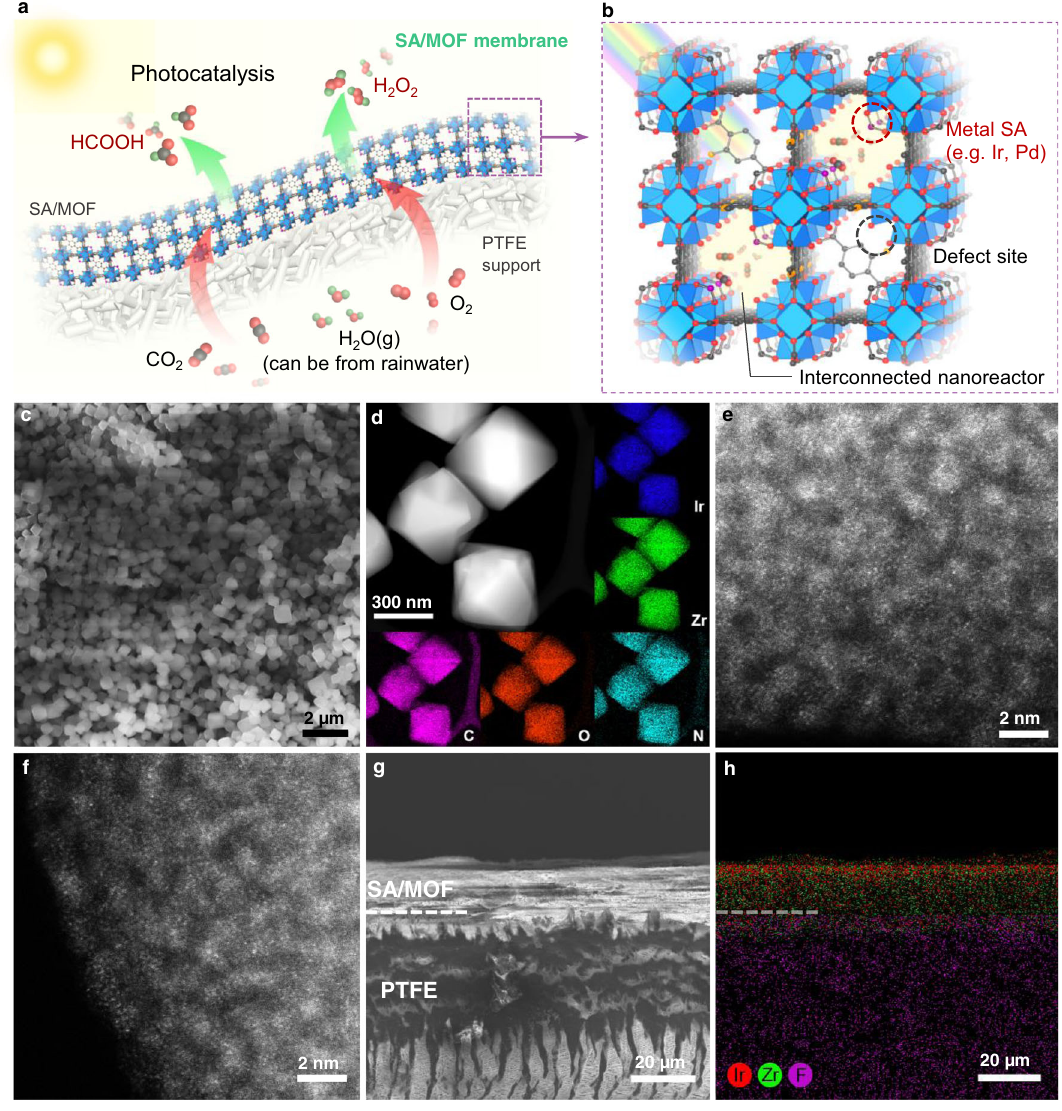
Fig. 1 Schematic illustration and structural characterization of the SA/MOF membranes. a Humidi fi ed gases (e.g., CO 2 , O 2 ) can be fed through the gas- permeable MOF/PTFE membranes and photocatalytically reduced to value-added chemicals (e.g., HCOOH and H 2 O 2 ) under visible light irradiation and ambient conditions. b With controllable defect-engineering, speci fi c metal SAs (e.g., Ir and Pd) can be precisely anchored on the edges of the Zr 6 O 4 (OH) 4 ( – CO 2 ) 12 − x octahedral to act as programable catalytic centers for catalyzing different reactions, such as photocatalytic CO 2 -to-HCOOH and